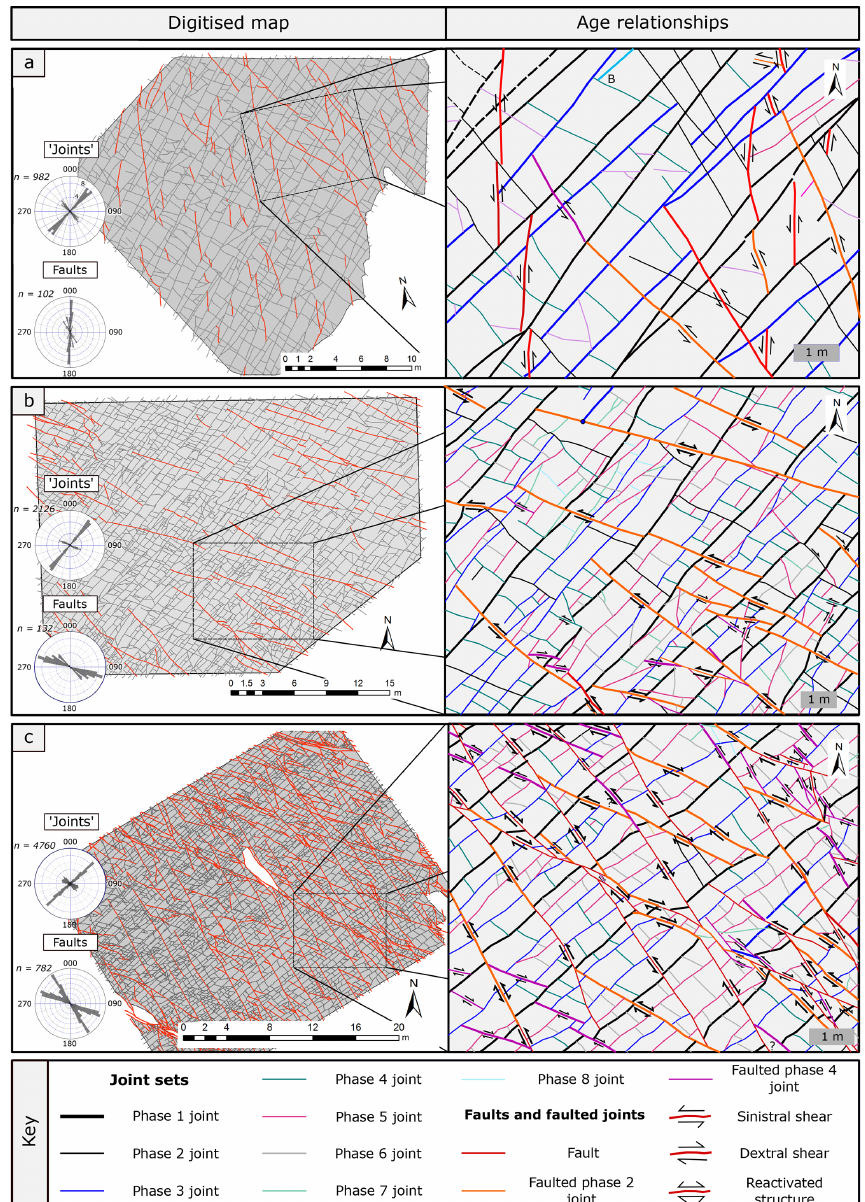
Figure 8. Fracture maps with increasing intensity of faulting. For each digitised map the exported fault (red lines) and “joint” (dark grey lines) maps, along with the interpretation areas used for the analysis (light grey), are provided. Please note that while it is possible some joint’s and/or faults acted as trailing segments (cf. Nixon et al., 2014), no direct field evidence was